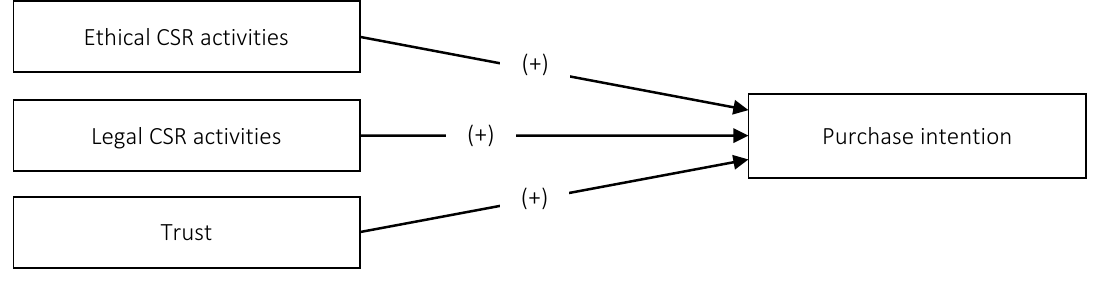
Figure 1. Research